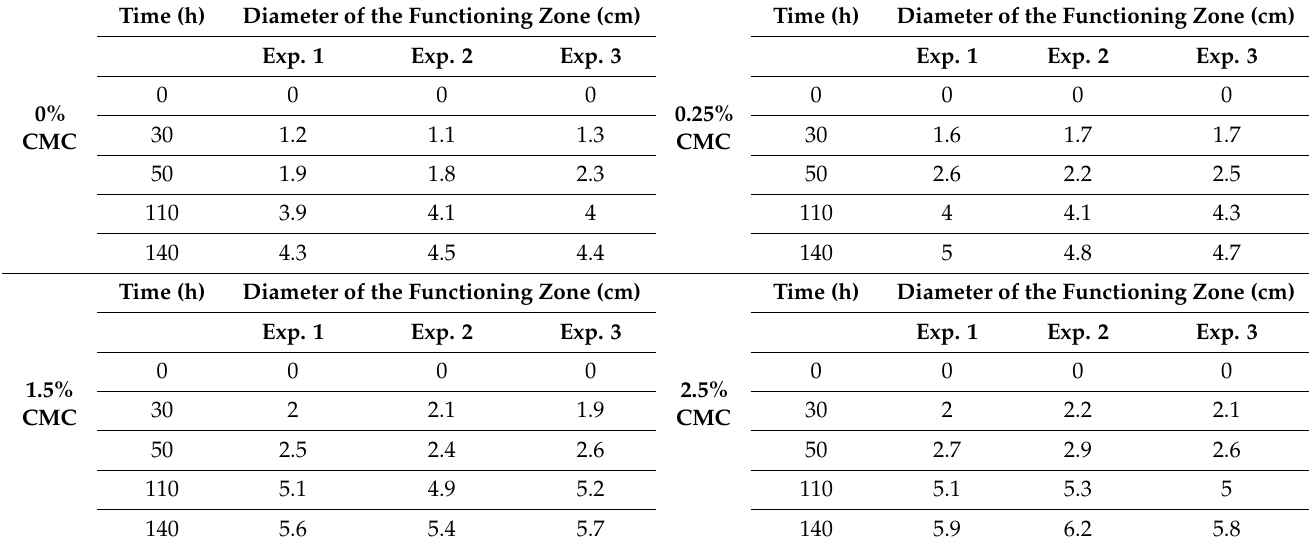
Table 1. The diameter of enzyme functioning zones recorded in the enzymatic cellulase examination in Figure 4b,c. Time (h) Diameter of the Functioning Zone